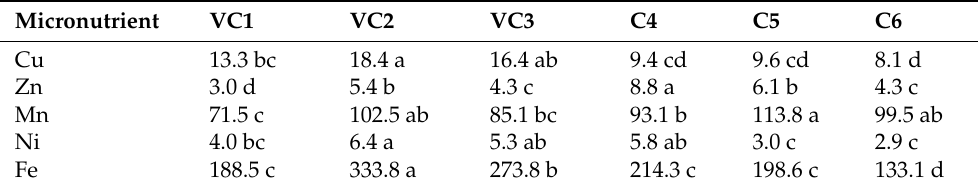
Table 4. Micronutrient total amounts in analyzed vermicomposts and composts (mg · kg − 1 ).